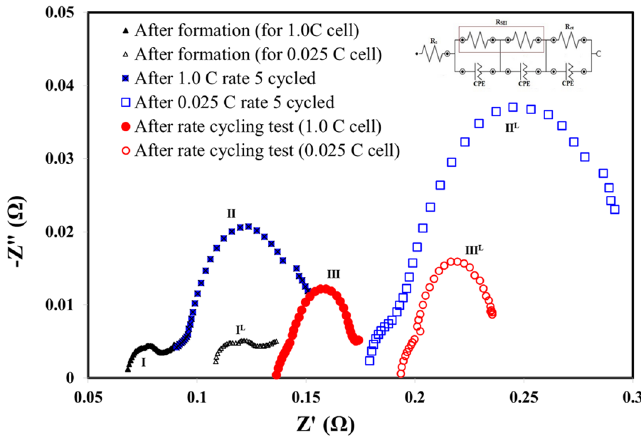
Figure 2. EIS plot of 1.0 C cell and 0.025 C cell after different cycled history. Inset shows the equivalent electrical circuit.